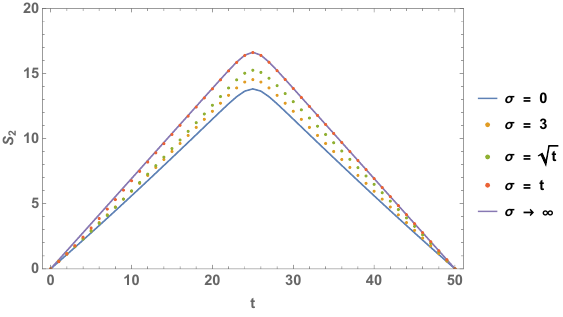
Figure 4 . Our results of second Rényi entropy S 2 for various values of σ with Q = 20 . The three finite σ cases are bounded in between by the two extreme cases ( σ → 0 and σ → ∞ ). N = 50 is